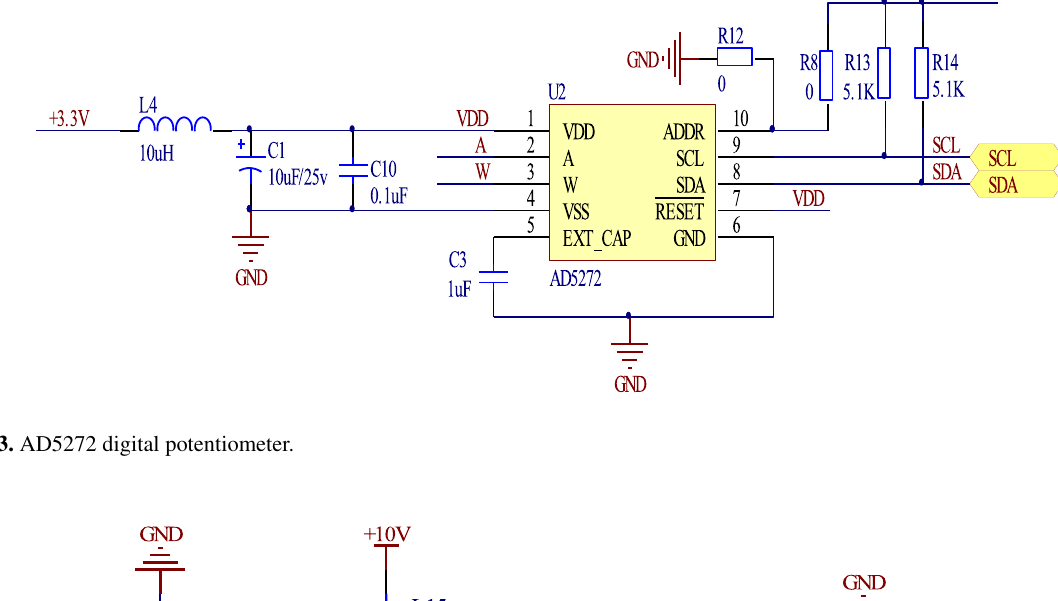
Figure 3. AD5272 digital potentiometer.